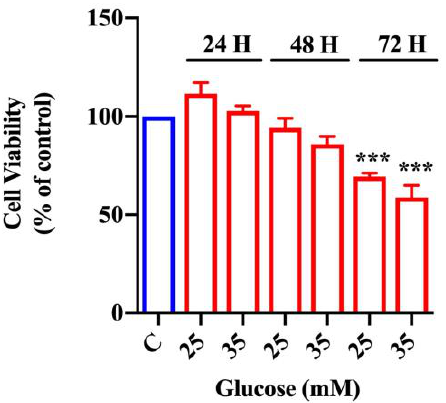
Figure 1. Effect of glucose on cell viability in intestinal organoids. MTT assay in intestinal organoids exposed to increasing concentrations of glucose (25 and 35 mM) after 24, 48, and 72 h (n = 6). Data are expressed as means ± SEM of 570 nM absorbance to % of control. One-way ANOVA followed by Bonferroni test: *** p < 0.001 with respect to control (C, 17.5 mM glucose).